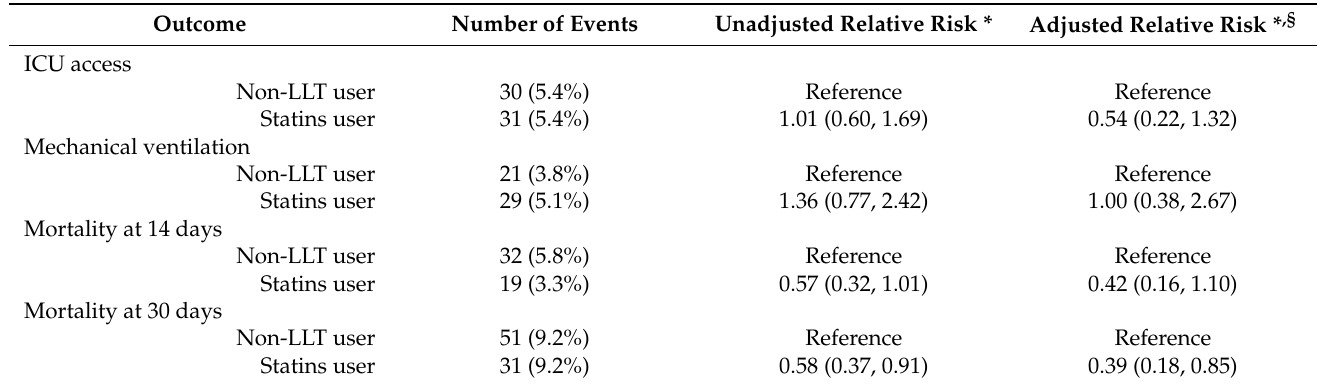
Table 2. Use of statins and ICU access, mechanical ventilation (MV), and mortality in patients with CVDs who tested positive for SARS-CoV-2 and were